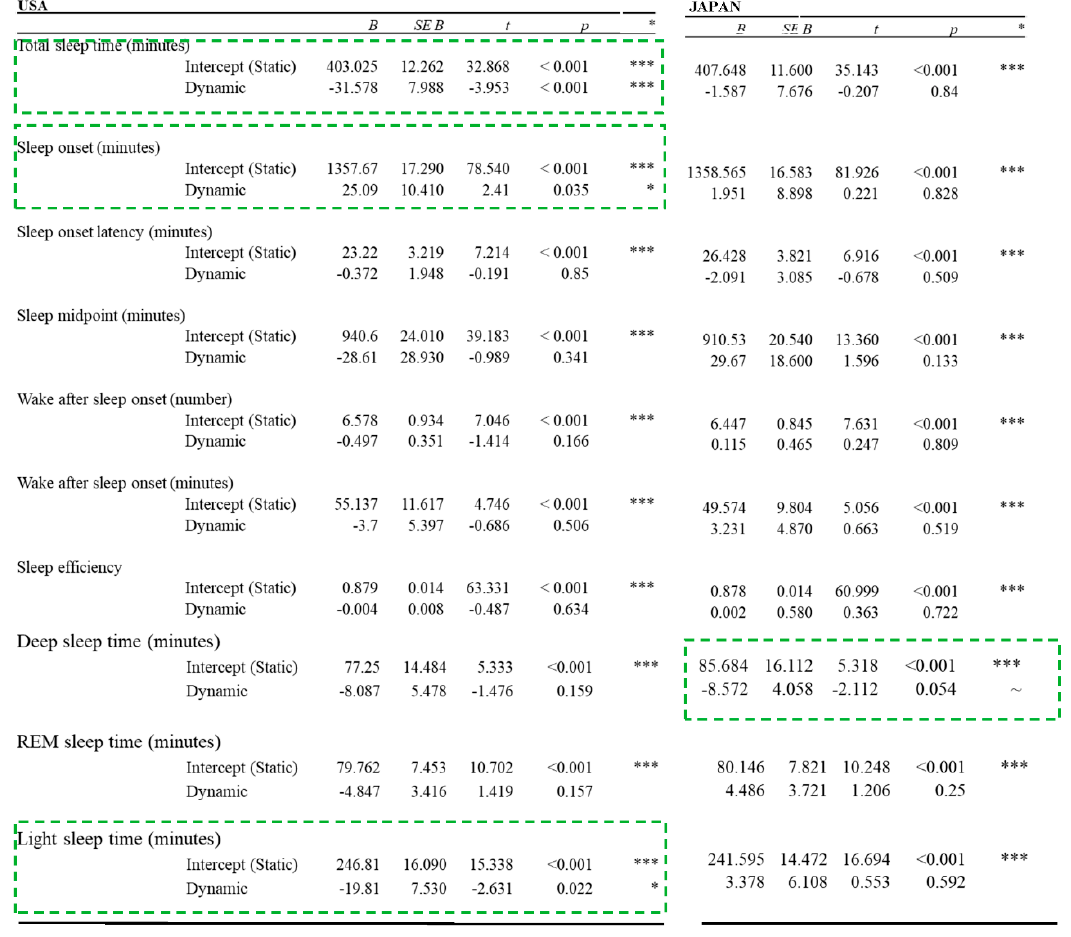
Table 3. Results for continuous objective sleep measurements.